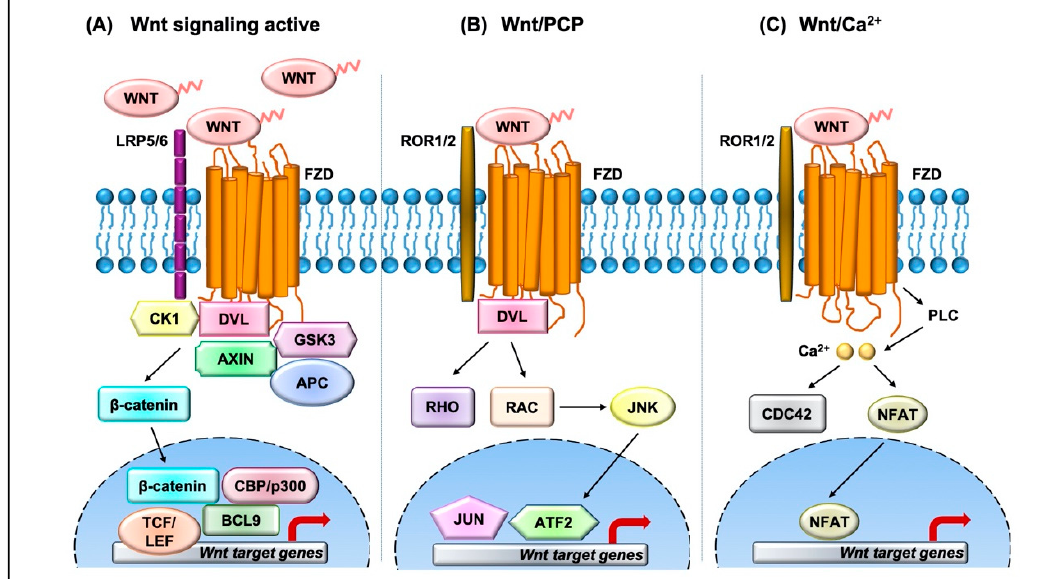
Figure 1. Overview of the Wnt signaling pathway. ( A ) In the canonical Wnt pathway, secreted Wnt ligands (usually Wnt3A and Wnt1) bind to Frizzled (FZD) receptors and LRP co-receptors. These receptors are then activated via CK1 and GSK3B mediated phosphorylation, which further recruits Dishevelled (DVL) to the plasma membrane and initiates activation. The DVL signalosome results in sequestration and inhibition of β -catenin destruction complex (Axin and APC) allowing stabilized β -catenin levels in the cytoplasm to increase. β -Catenin translocates into the nucleus where it forms an active complex with lymphoid enhancer factor (LEF), T-cell factor (TCF), and other histone-modifying co-activators such as CBP / p300 and BCL9, resulting in transcriptional activation (as represented by red arrow) of Wnt target genes which in turn causes an increase in cellular processes such as cell proliferation and di ff erentiation and stem cell renewal. ( B ) In the Wnt / PCP pathway, Wnt ligands bind to FZD and co-receptors such as ROR1 / 2 and recruit DVL to the plasma membrane. DVL interacts with small GTPases such as RHO and RAC to further trigger activation of JNK. This results in activation of cytoskeletal rearrangements by transcriptional responses via JUN and ATF2 (activating transcription factor). ( C ) The Wnt / Ca 2 + pathway is initiated by Wnt-FZD-ROR complex and G-protein-triggered phospholipase C (PLC) activity that results in intracellular Ca 2 + influx. This further activates CDC42 and triggers calcium-dependent cell movement and polarity via various transcriptional responses (red